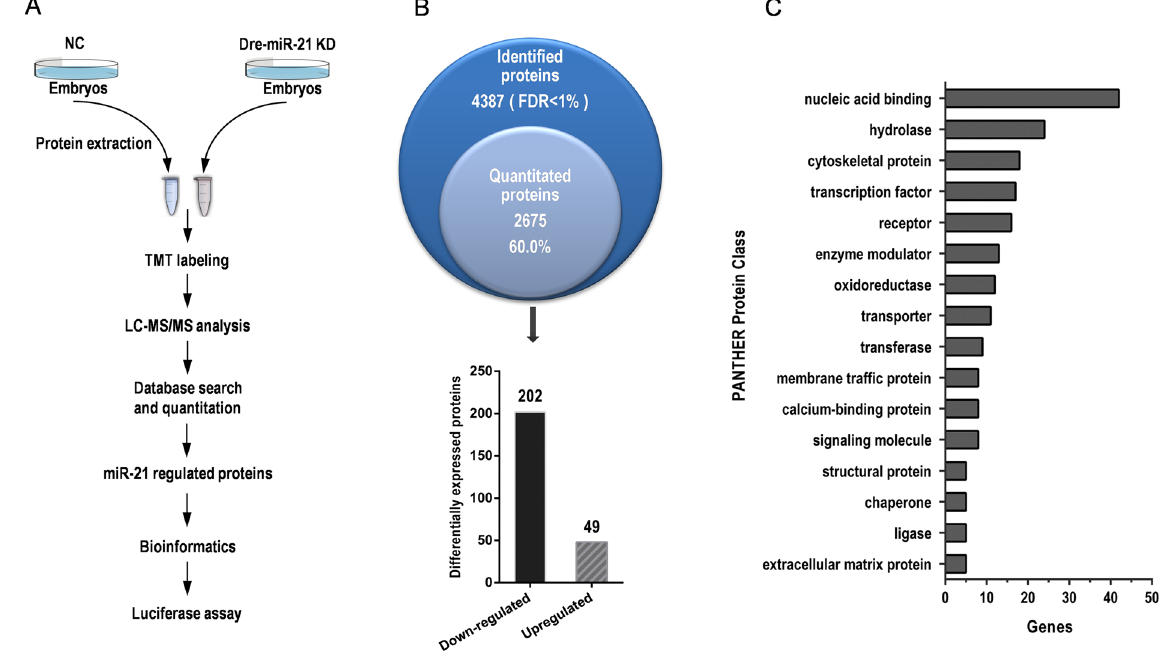
Figure 2. Quantitative proteomic identification of miR-21-regulated proteins in zebrafish embryos. ( A ) Workflow for the identification of miR-21-regulated proteins. ( B ) Overview of the proteomic results. ( C ) PANTHER Protein Class ontology classification of the 251 proteins differentially expressed after miR-21 knockdown.